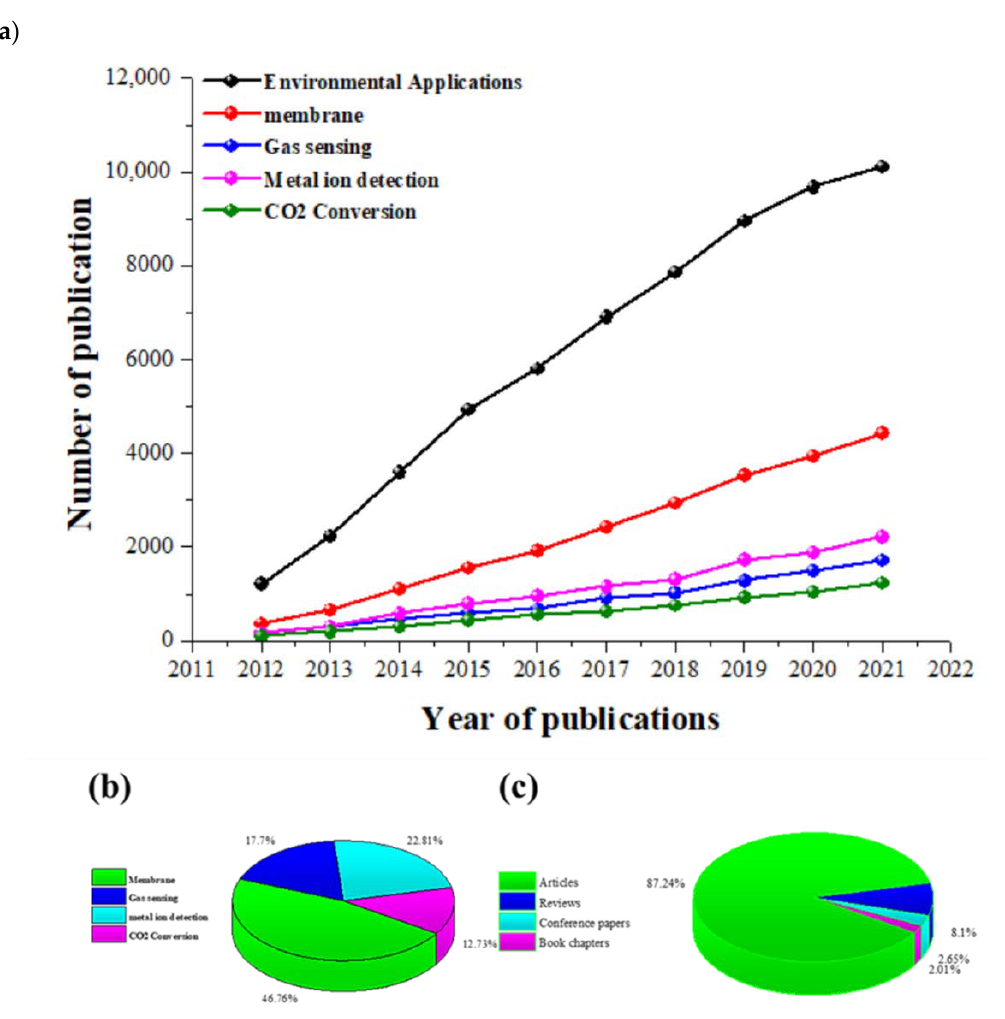
Figure 25. ( a ) Publication trend of graphene in environmental applications from 2010 until 2021, ( b ) The percentage publications graphene in each environmental application, ( c ) Type of publications of the environmental application of graphene. All self-extracted from Scopus (www.scopus.com) (accessed on 11 September 2022).